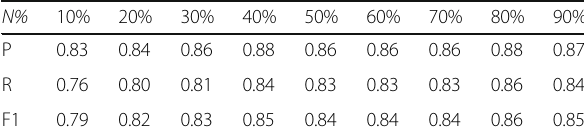
Table 6 The influence of the sorting-purpose polynomial proportion in classification decision function of the GVCA method on the classification performance